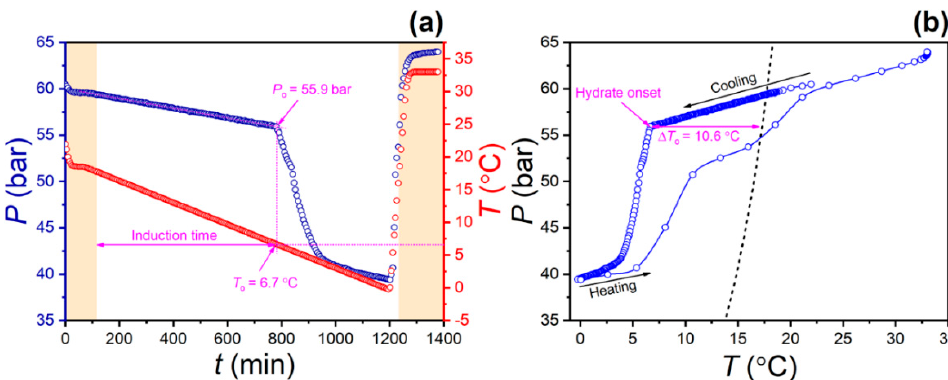
Figure 1. ( a ) Typical result of ramping experiment for a polyurethane solution (0.5 wt% WPU-3); color-filled areas correspond to P , T -conditions outside the thermodynamic stability of gas hydrate, white area matches hydrate stability zone; ( b ) P , T -curve illustrating the determination of hydrate onset subcooling ( Δ T o ); dashed line—experimental data for the equilibrium conditions of hydrate formation for the gas mixture [40]. Table 1. The results of ramping experiments by rocking cell technique.